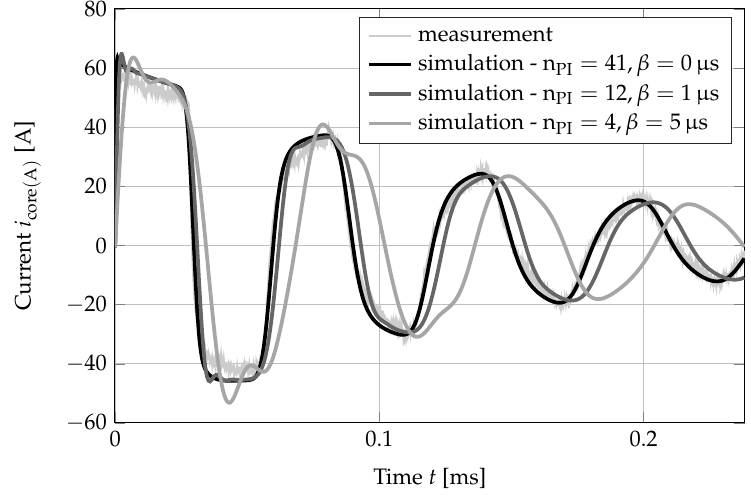
Figure 15. Comparison of simulated currents by different number of PI-sections with